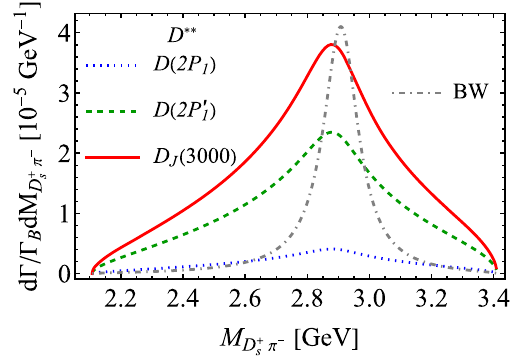
Fig. 4 Invariant mass distributions of D + s π − via the rescatterings in Fig. 1b. The mass and width of intermediate state D ∗∗ are taken to be those of D ( 2 P 1 ) (dotted line), D ( 2 P (cid:8) (solid line), separately. The dot-dashed line indicates the rescaled T c ¯ s ( 2900 ) BW resonance curve for